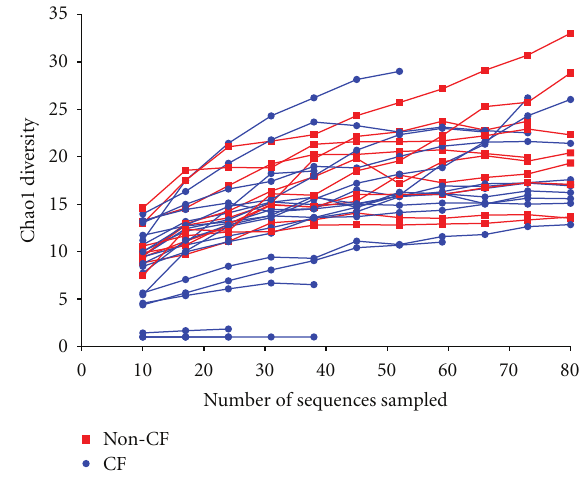
Figure 1: Rarefaction curves estimating the e ff ect of sampling on Chao1 diversity measurements. The sequence data were resampled 100 times in Qiime [29], and, for each sample, the Chao1 diversity measurement was estimated. Red lines indicate bronchiectasis patients, whereas blue lines indicate cystic fibrosis (CF)